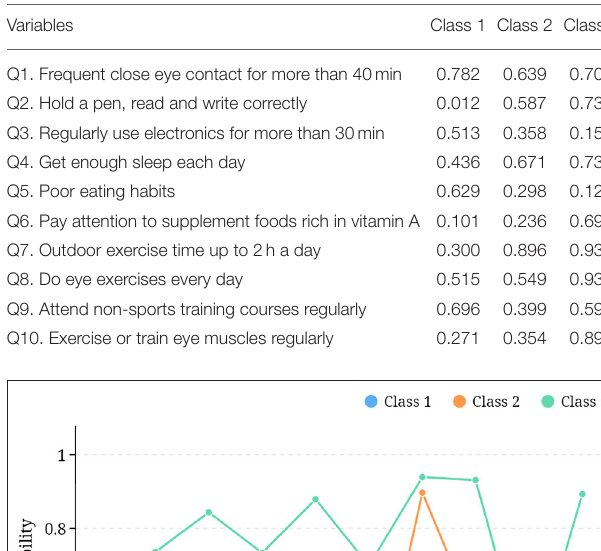
TABLE 4 | The conditional probability of the latent class of adolescent eye care behavior.